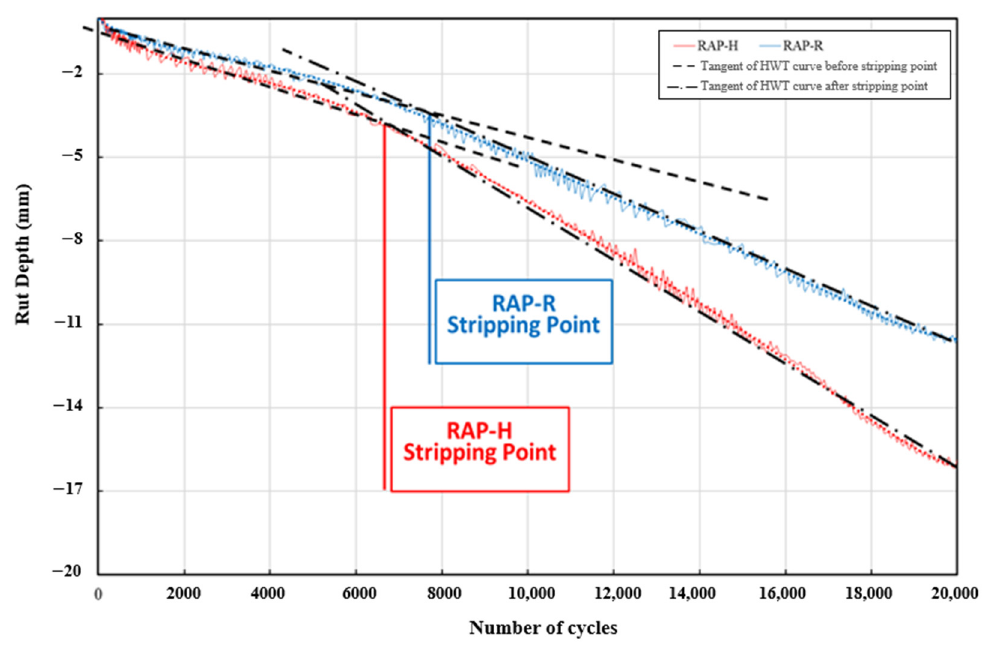
Figure 11. Result of Hamburg wheel tracking test.